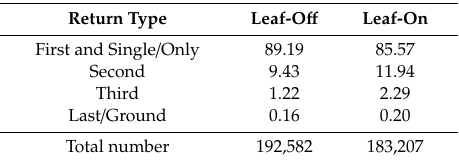
Table 3. Percentage of di ff erent laser returns for all channels within all plots ( n = 12) in leaf-o ff and leaf-on data. Return